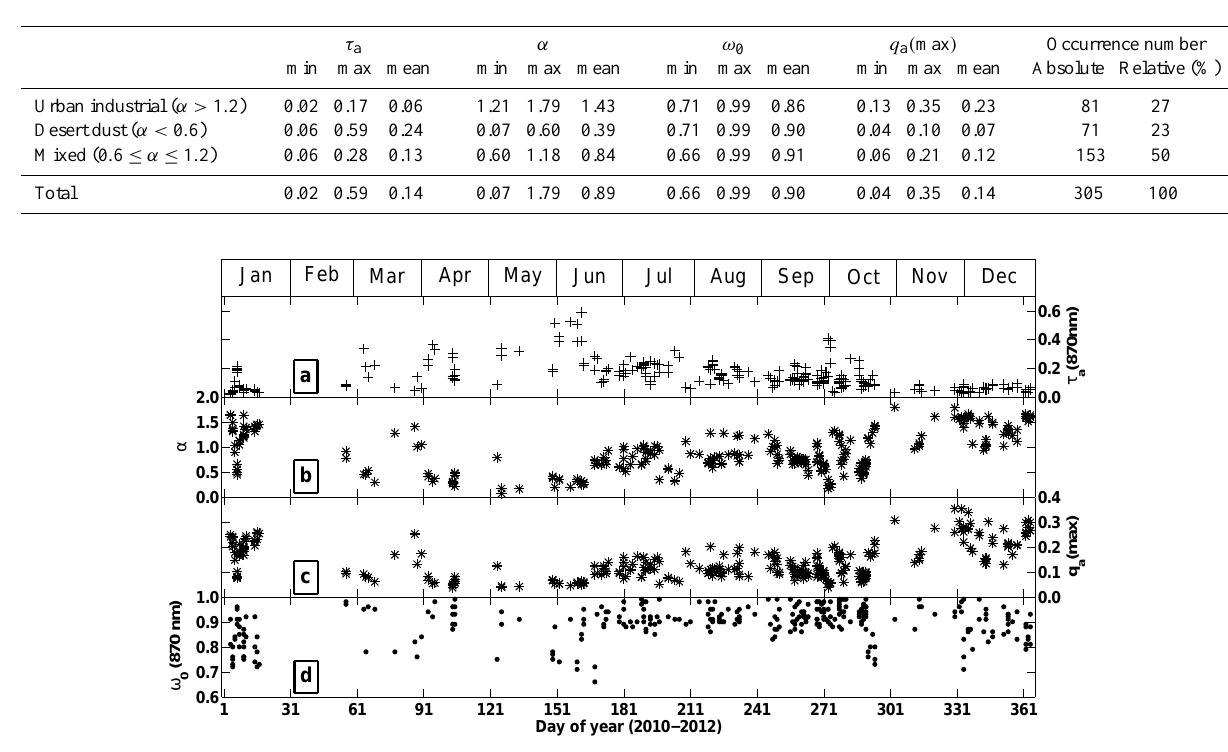
Fig. 3. (a) τ a (870nm), (b) α , (c) q a ( max ) , and (d) ω 0 retrieved values versus day of year, February 2010 to December 2012, IASBS site. Table 2. Minimum (min), maximum (max), and mean values of τ a , α , ω 0 , and q a (max) for 305 selected measurements, in each dominated category of aerosols in Zanjan’s atmosphere, February 2010 to December 2012, IASBS site. τ a α ω 0 q a (max) Occurrence number min max mean min max mean min max mean min max mean Absolute Relative (%) Urban industrial ( α> 1 . 2 ) 0.02 0.17 0.06 Desert dust ( α< 0 . 6 )